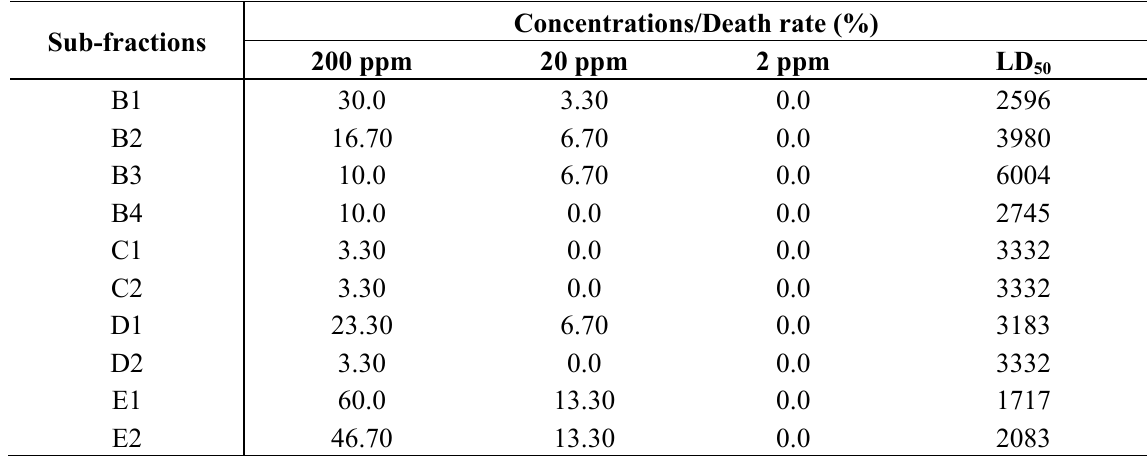
Table 3. Lethality of T. indica sub-fractions on Brine shrimp.